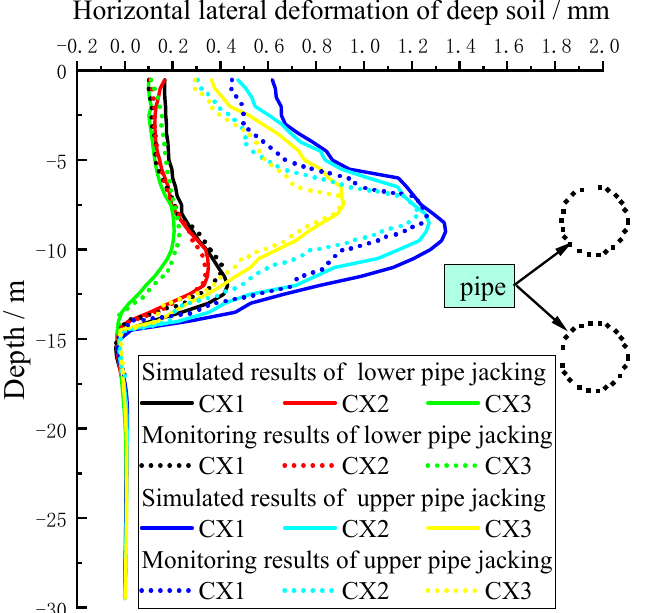
Figure 11. Comparisons of horizontal lateral displacement produced by pipe jacking.